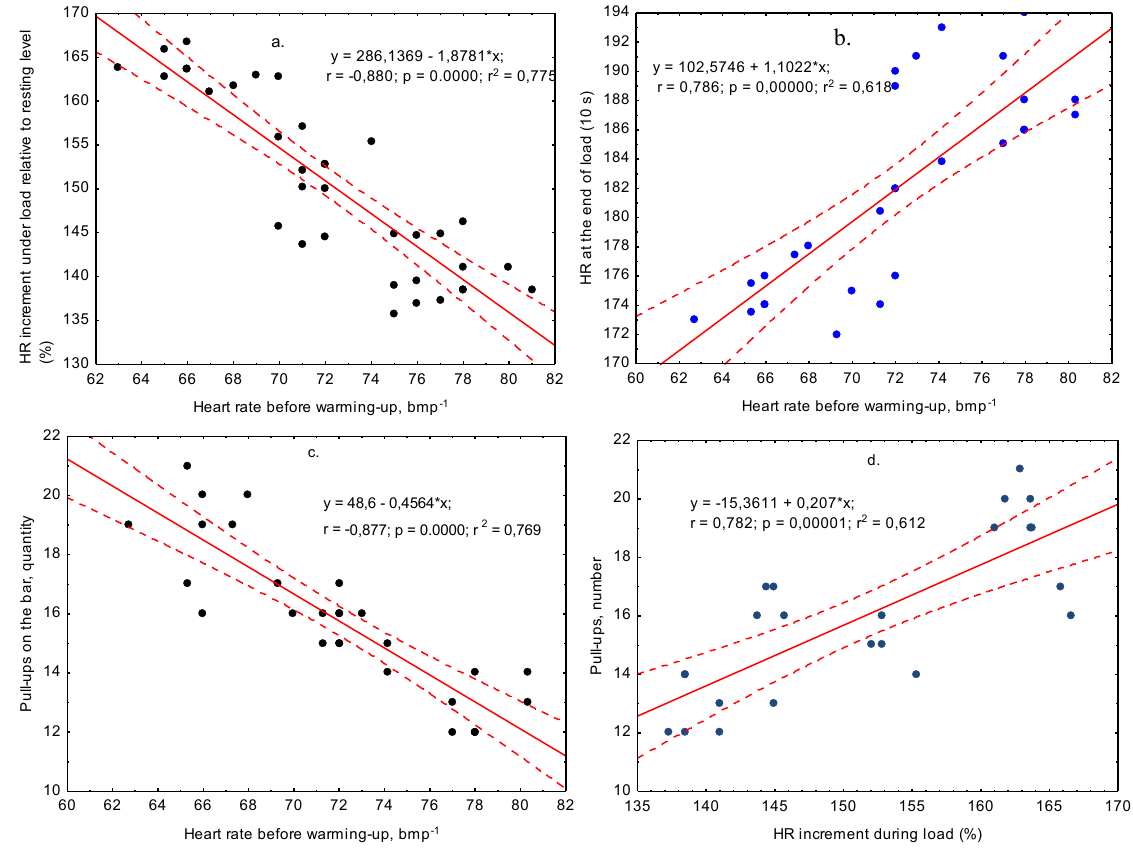
Figure 3. Correlations of HR in different states during muscular activity with each other and the number of